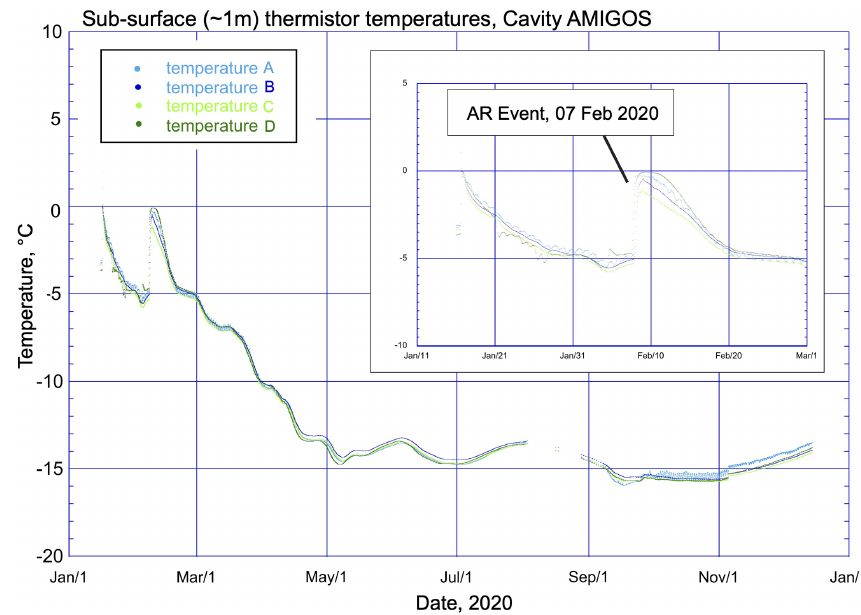
Figure A2. Firn temperature time series during the February 2020 AR event from 4 thermistors (A–D), all placed 1m below the surface at Cavity